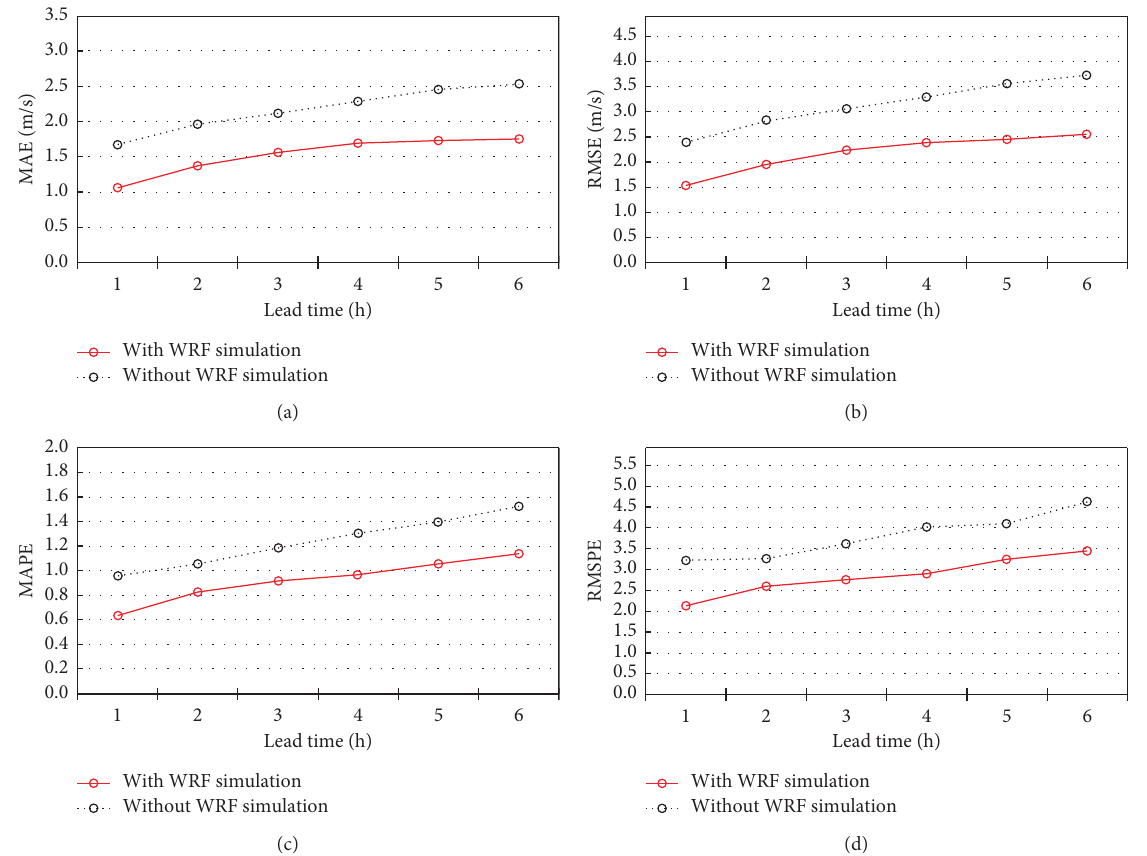
Figure 15: Performance measures of predictive accuracy for the use and nonuse of WRF simulation values on the Yilan gauge: (a) MAE, (b) RMSE, (c) MAPE, and (d)